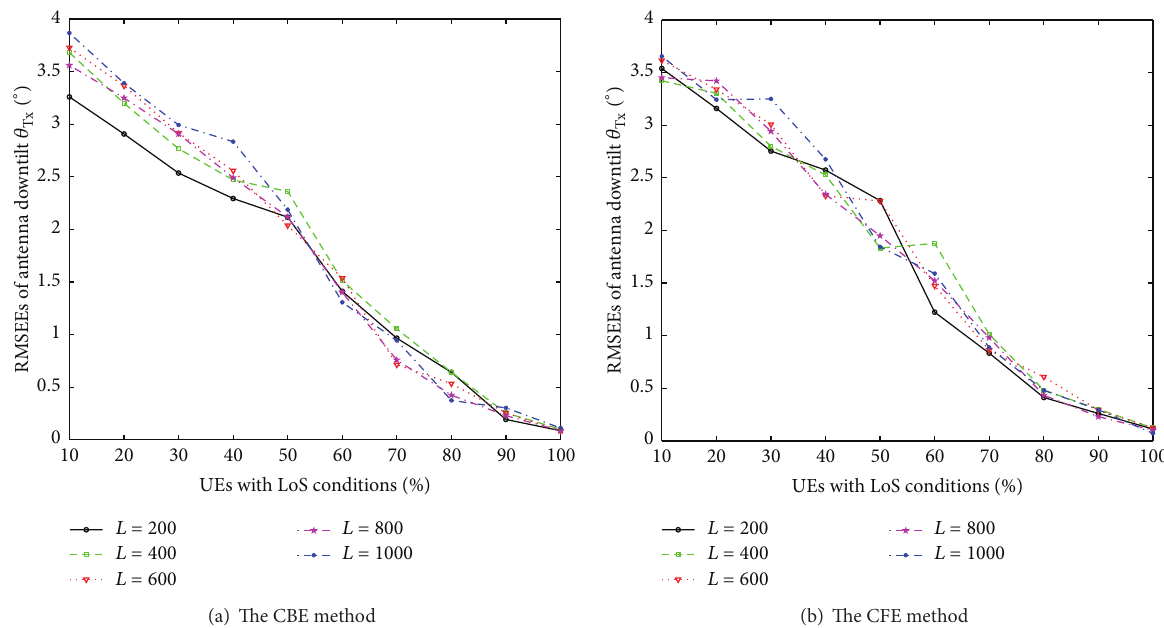
Figure 9: The RMSEEs of antenna downtilt versus the percentage of the LoS users with the total number of users as a parameter.